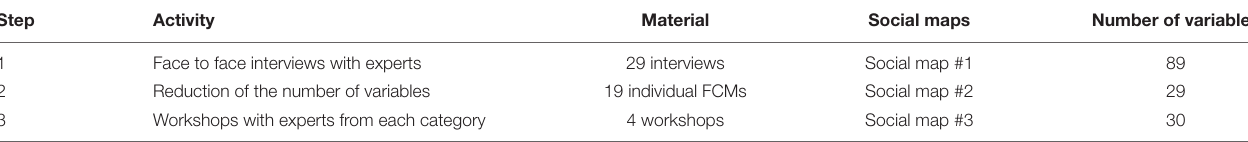
TABLE 1 | Steps of the expert consultation process and links with the successive social maps